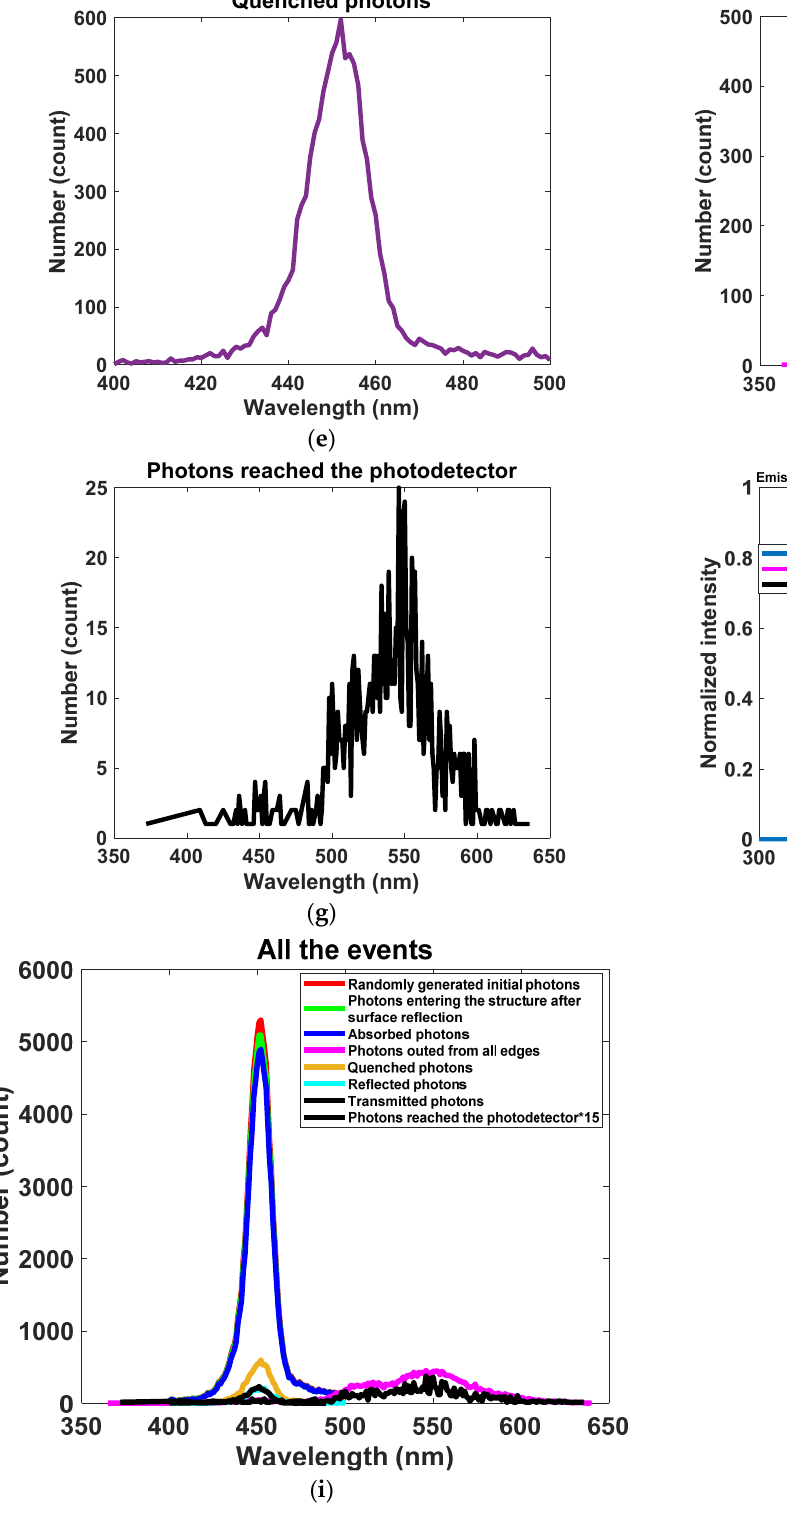
Figure 8. Results after Monte-Carlo simulation. ( a ) Incident photons (randomly generated). ( b ) Reflected photons. ( c ) Transmitted photons. ( d ) Absorbed photons. ( e ) Quenched photons. ( f ) Photons came out from all edges. ( g ) Photons reached the photodetector. ( h ) Emission spectra of graphene collected photons, and photons came out from all edges in one figure. ( i ) All events in one figure.